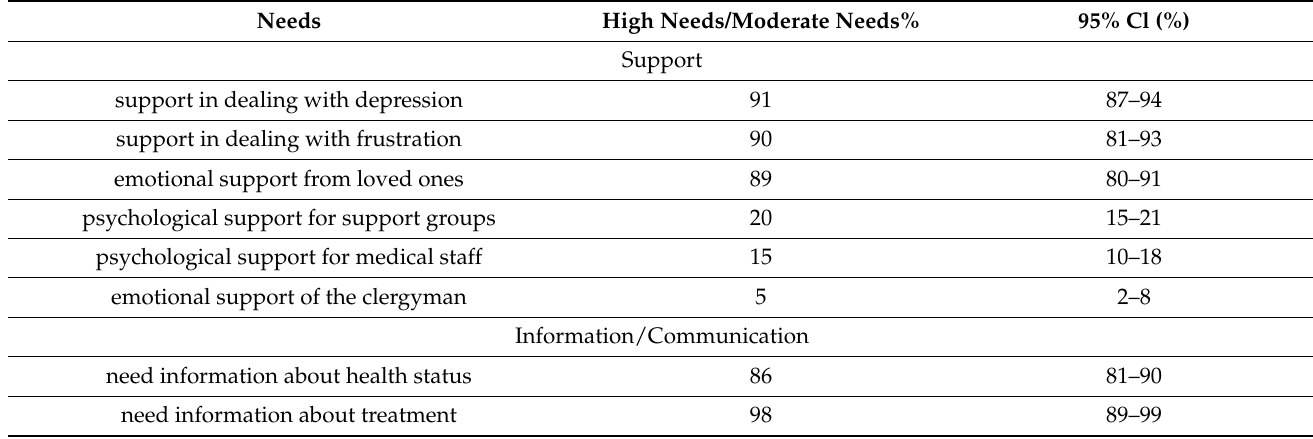
Table 5. Patients’